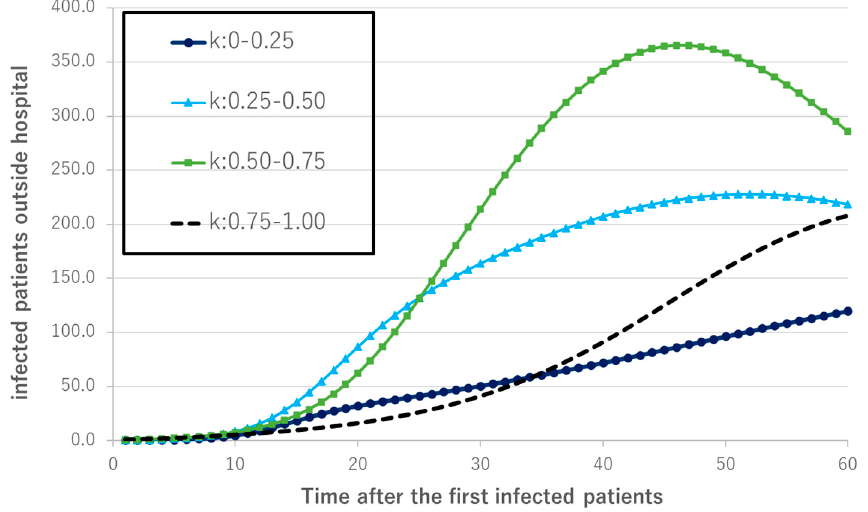
Figure 7. Number of people infected outside the hospital.